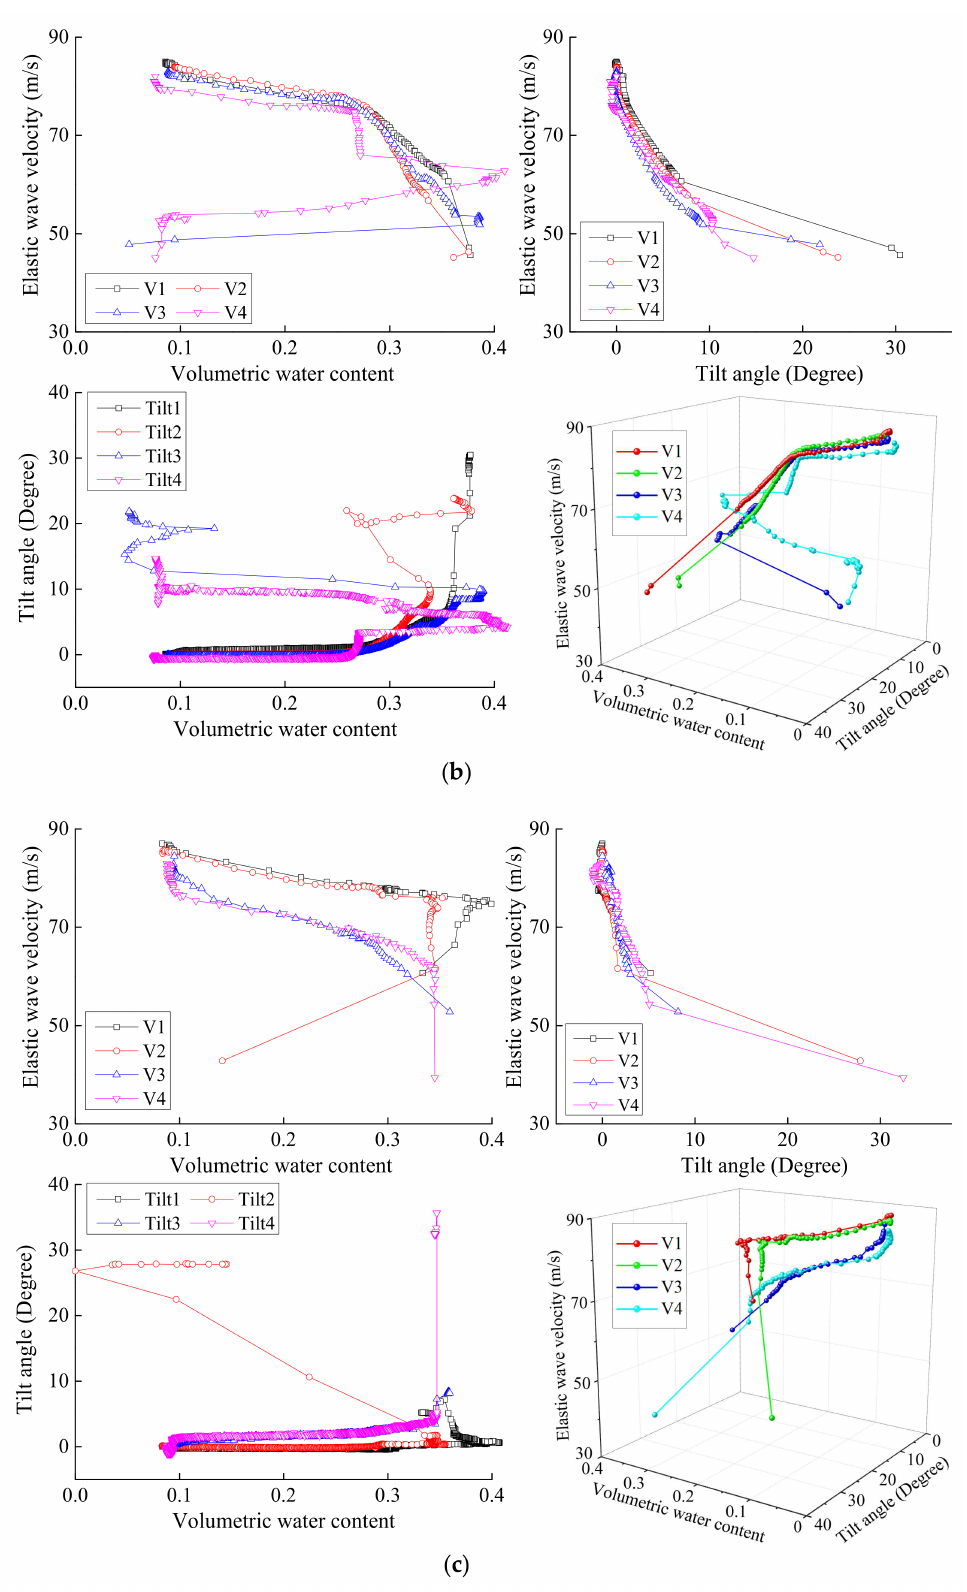
Figure 10. Relationship between elastic wave velocity against volumetric water content and tilt angle by fixed model tests with surface layer thickness of ( a ) 5 cm, ( b ) 10 cm and ( c ) 15